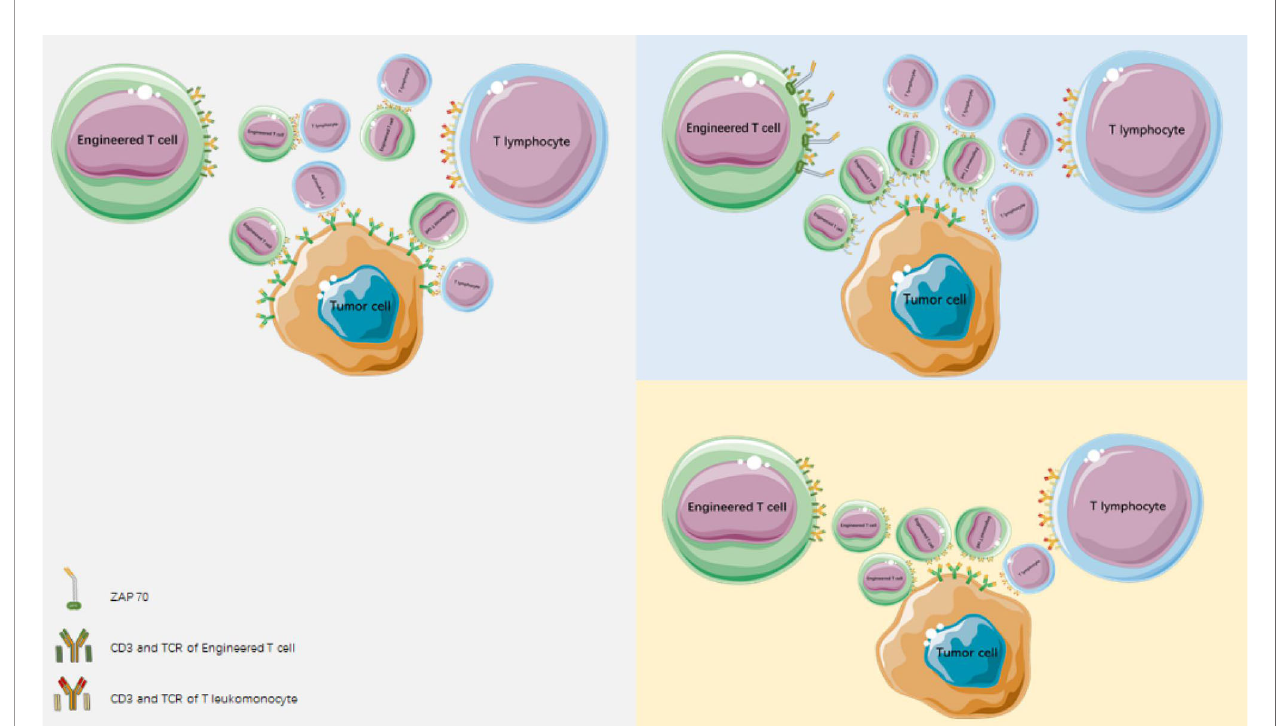
FIGURE 2 | Reducing mismatches between endogenous and heterogeneous TCR and reducing competition for CD3 molecules can mediate an increase in surface expression of modi fi ed TCR